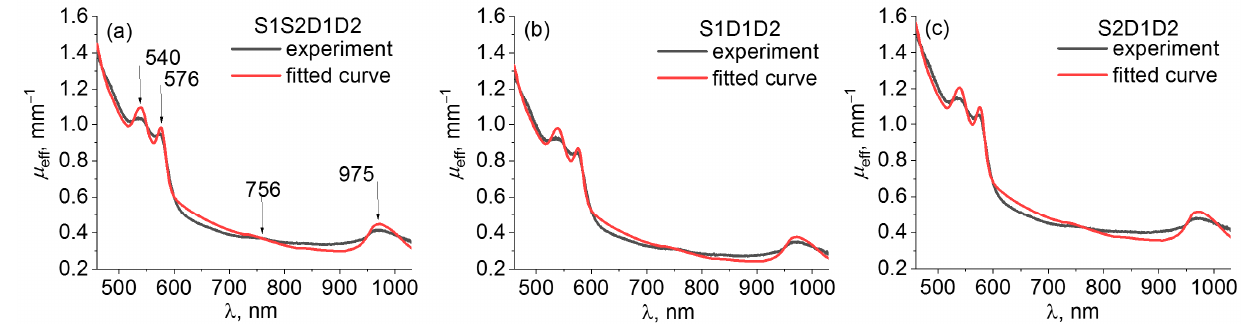
Figure 6. Fitting the extinction spectra of the in vivo human palm obtained from unperturbed measurements using ( a ) S1S2D1D2, ( b ) S1D1D2, and ( c ) S2D1D2 approaches with the reconstructed extinction spectra using Equations. (11)–(13).